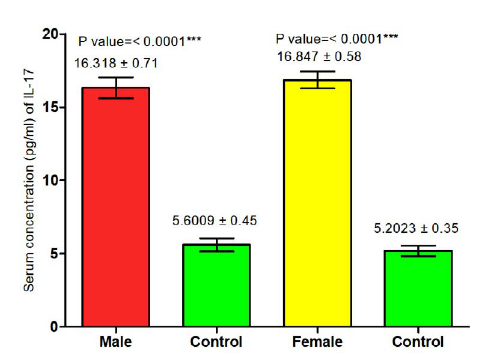
Fig. 8. Comparison between serum level of IL-17 in total patients and total control with Sarcoptes scabiei and control